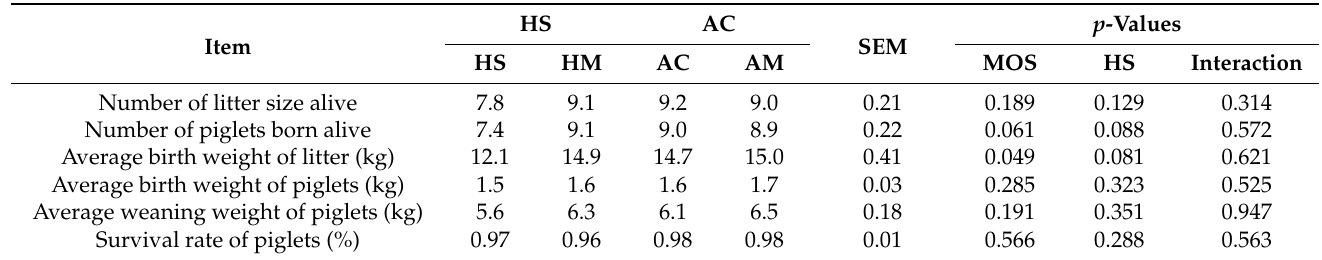
Table 3. Effects of dietary supplementation with MOS on the reproductive performance of sows under the HS or AC conditions.